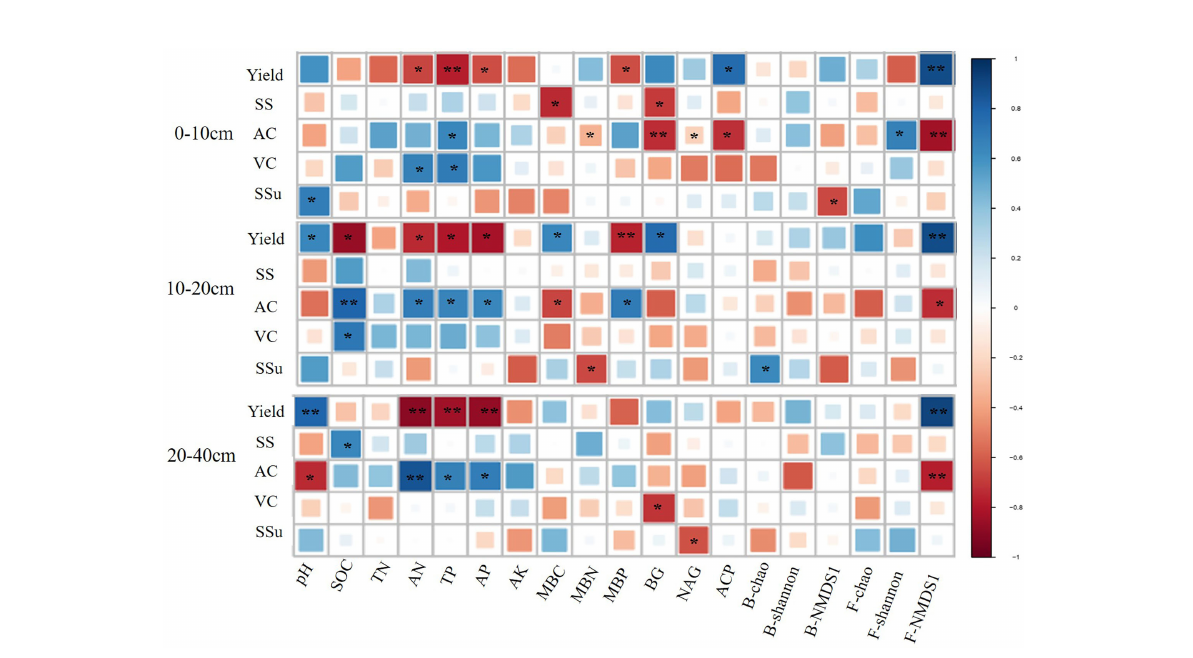
FIGURE 4 Relationship between soil quality indicators, pear yield and quality at different depths. * and ** represent the signi fi cant at 0.05 and 0.01 level, respectively. SOC, soil organic carbon; TN, total nitrogen; TP, total phosphate; AN, alkalihydrolysable N; AP, available phosphate; AK, available potassium; MBC, microbial biomass carbon; MBN, microbial biomass nitrogen; MBP, microbial biomass phosphorus. BG, b -D-glucosidase; NAG, b -Nacetylglucosaminidase; ACP, acid phosphatase; B-chao, bacterial chao index; B-shannon, bacterial Shannon index; B-NMDS1, non-metric multidimensional scaling (NMDS) axis 1 values of the bacterial community; F-chao, fungal chao index; F-shannon, fungal shannon index; F-NMDS1, non-metric multidimensional scaling (NMDS) axis 1 values of the fungal community; SS, Soluble solids; AC, Titratable acids; VC, Vitamin C; SSu, Soluble